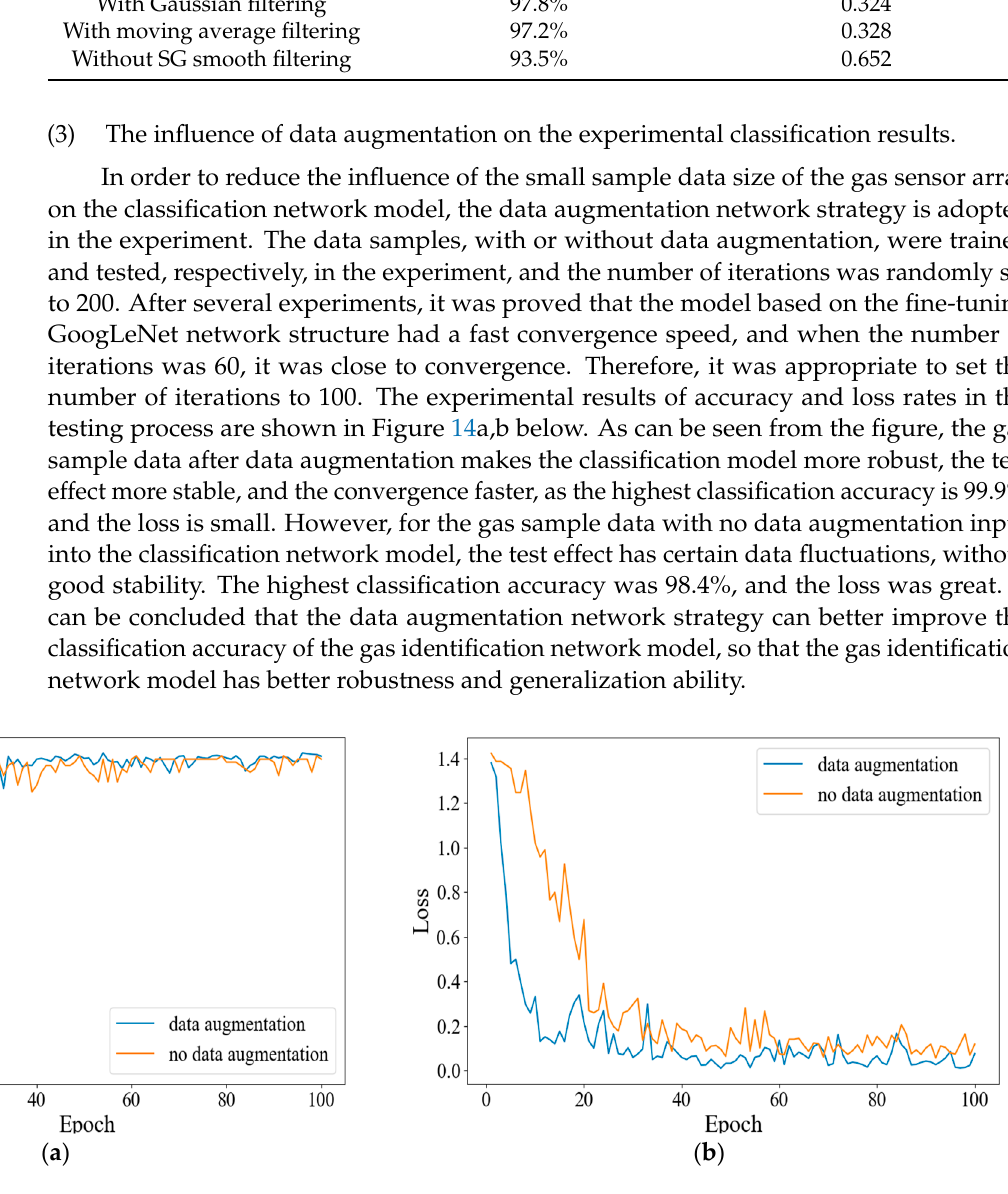
Figure 14. ( a ) Training and accuracy curves with and without data augmentation experiment. ( b ) Training and test loss curves with and without data augmentation experiment.